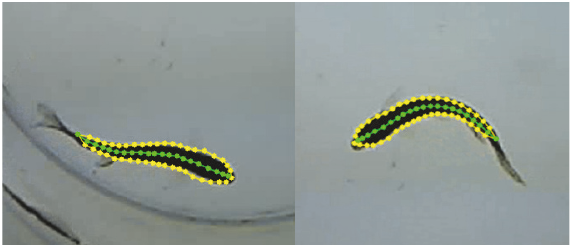
Figure 6: Individual fishes represented by deformable models (yellow contour) and their skeletons (green line) [24].